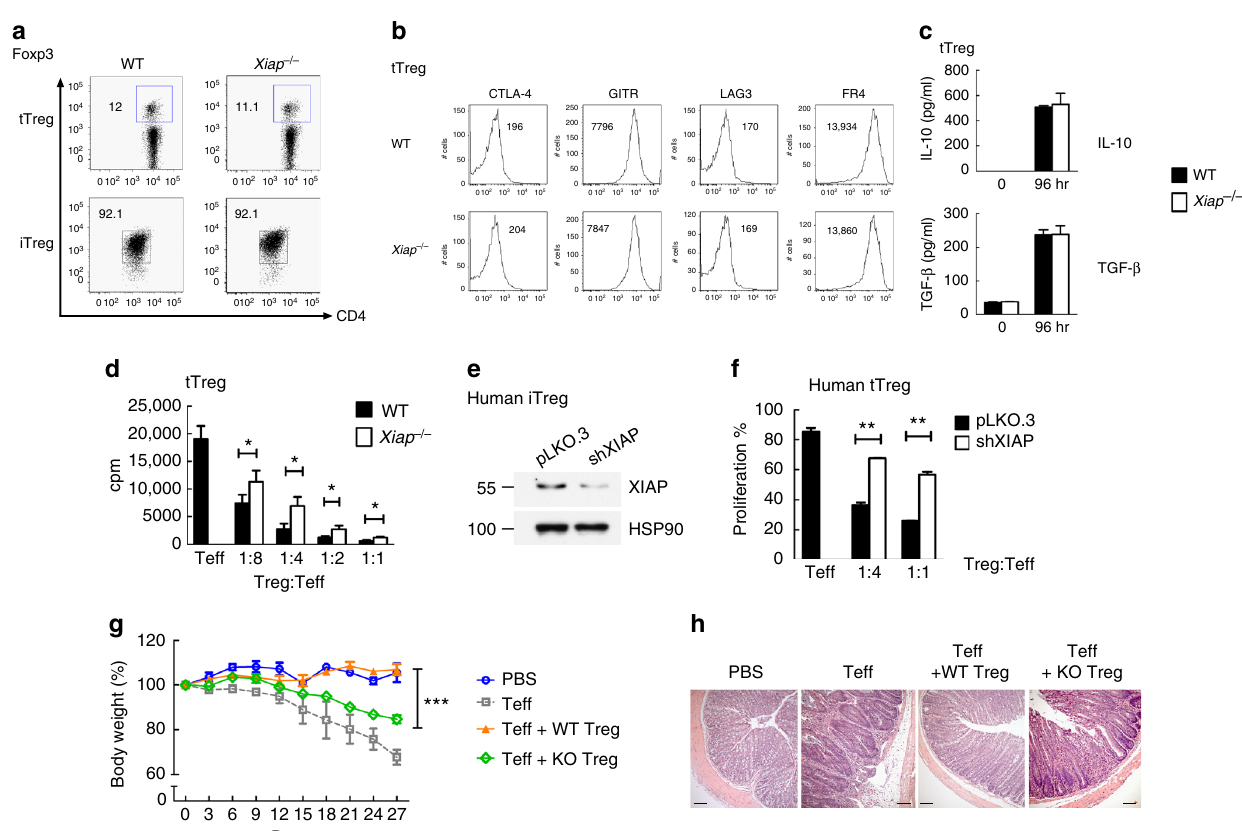
Fig. 1 XIAP-de fi ciency impairs Treg cell suppressive function. a Comparable control and Xiap − / − tTreg cells and iTreg cells development. The fractions of splenic CD4 + Foxp3 + population from control (WT) and Xiap − / − mice were determined (tTreg). WT and Xiap − / − CD4 + CD25 − T cells were treated with anti-CD3/CD28 plus TGF- β and IL-2, and Foxp3 expression at day 5 was assessed (iTreg). Experiments were independently repeated six times. b XIAP- de fi ciency does not affect the Treg cells phenotype. Expressions of CTLA-4, GITR, LAG3 and FR4 in WT and Xiap − / − tTreg cells were determined. Numbers indicate mean fl uorescence intensities. c Normal IL-10 and TGF- β production in Xiap − / − tTreg cells. CD4 + CD25 + cells were stimulated with anti-CD3/ CD28 and IL-2 for 96 h, before generation of IL-10 and TGF- β was determined. d Impaired in vitro suppressive activity of Xiap − / − tTreg cells. CD4 + CD25 - cells were incubated with anti-CD3, antigen-presenting cells, and the indicated ratios of WT and Xiap − / − CD4 + CD25 + tTreg cells. [ 3 H]thymidine incorporation was determined at 80 h. Values are mean ± SD of triplicate samples in an experiment. * P < 0.05, ** P < 0.01 for unpaired t -test. Experiments were reproduced independently three times with similar outcomes. e Knockdown of XIAP in human Treg cells. The levels of XIAP in control (pLKO.3) and XIAP-knockdown human iTreg cells were determined by immunoblots. f Impaired suppressive activity in XIAP-de fi cient human tTreg cells. Human effector T cells (Teff) were labeled with 2 μ M CFSE, activated by anti-CD3/CD28 in the presence of the indicated ratio of human control and XIAP-knockdown tTreg cells, and collected at 72 h. Proliferation was determined by gating CD4 + T cells for their CFSE intensity in fl ow cytometry. g , h Diminished inhibitory activity of Xiap − / − tTreg cells in vivo. CD4 + CD25 − effector T cells were administered intraperitoneally into Rag1 − / − mice with WT or Xiap − / − tTreg cells. Body weight was determined at the indicated time-points ( g ). Data are the mean ± SD of six mice in each group. *** P < 0.001 for two-way ANOVA. Mice were killed at day 27 and colons were removed, fi xed in paraformaldehyde, sectioned, and stained with H&E. Micrographs are representative of the six